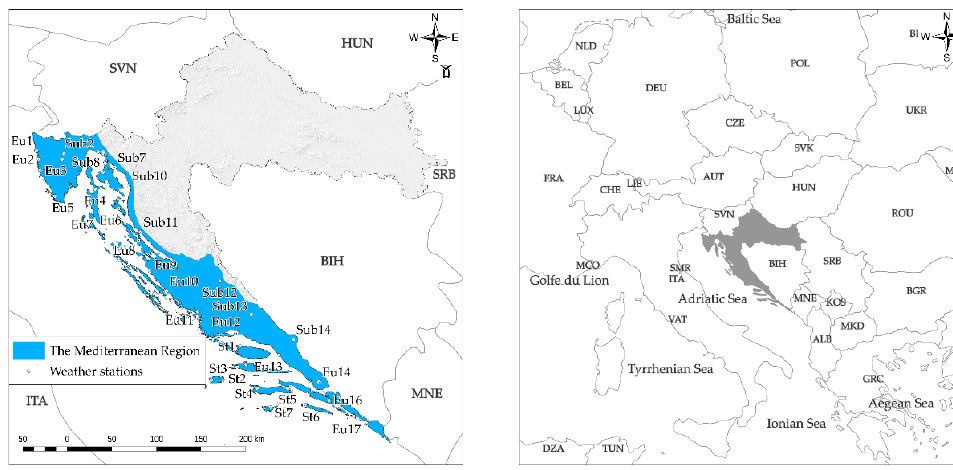
Figure 1. Mediterranean vegetation belt in the research area with the position of weather stations.